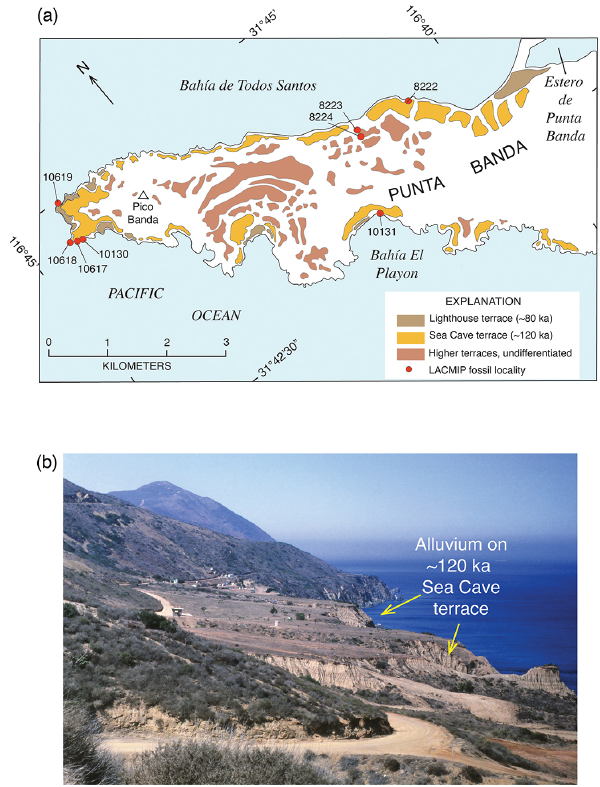
Figure 31. (a) Map of the Punta Banda area, south of Ensenada, Baja California (see Fig. 30 for location). Lighthouse terrace is dated to MIS 5a ( ∼ 80ka), and Sea Cave terrace is dated to MIS 5e ( ∼ 120ka), both by U-series on corals (Rockwell et al., 1989; Muhs et al., 2002a). Terrace mapping is redrawn from Rockwell et al. (1989). (b) Photograph of the ∼ 120ka Sea Cave terrace on the northeast side of Punta Banda, showing thick alluvial cover. Photo- graph by Daniel R.